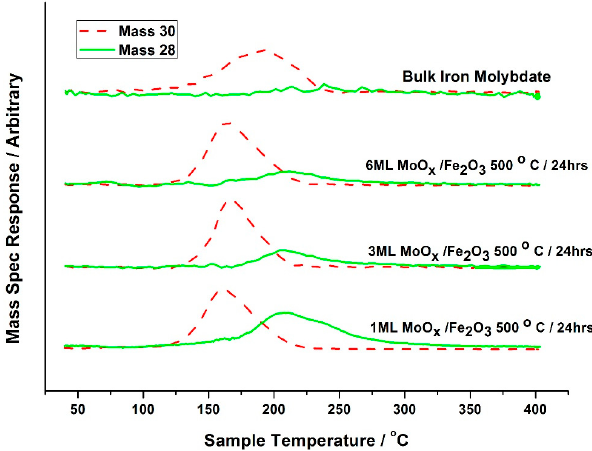
Figure 10. TPD data obtained for 1, 3 and 6ML’s MoO x /Fe 2 O 3 , after calcining at 500 °C for 24 h and dosing with methanol at ambient temperature, with noticeable reduction in CO production.